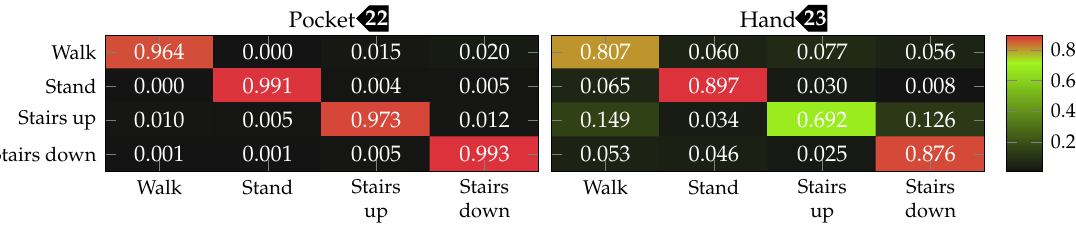
Figure 28. Confusion matrices for both pocket-case and hand-case, when evaluated separately on a model trained on the combination of both datasets. As model, the approach based on analytical transformations with a PCA, 5 remaining dimensions, a window length of 2s, raw acceleration, and an SVM classifier with the RBF kernel was